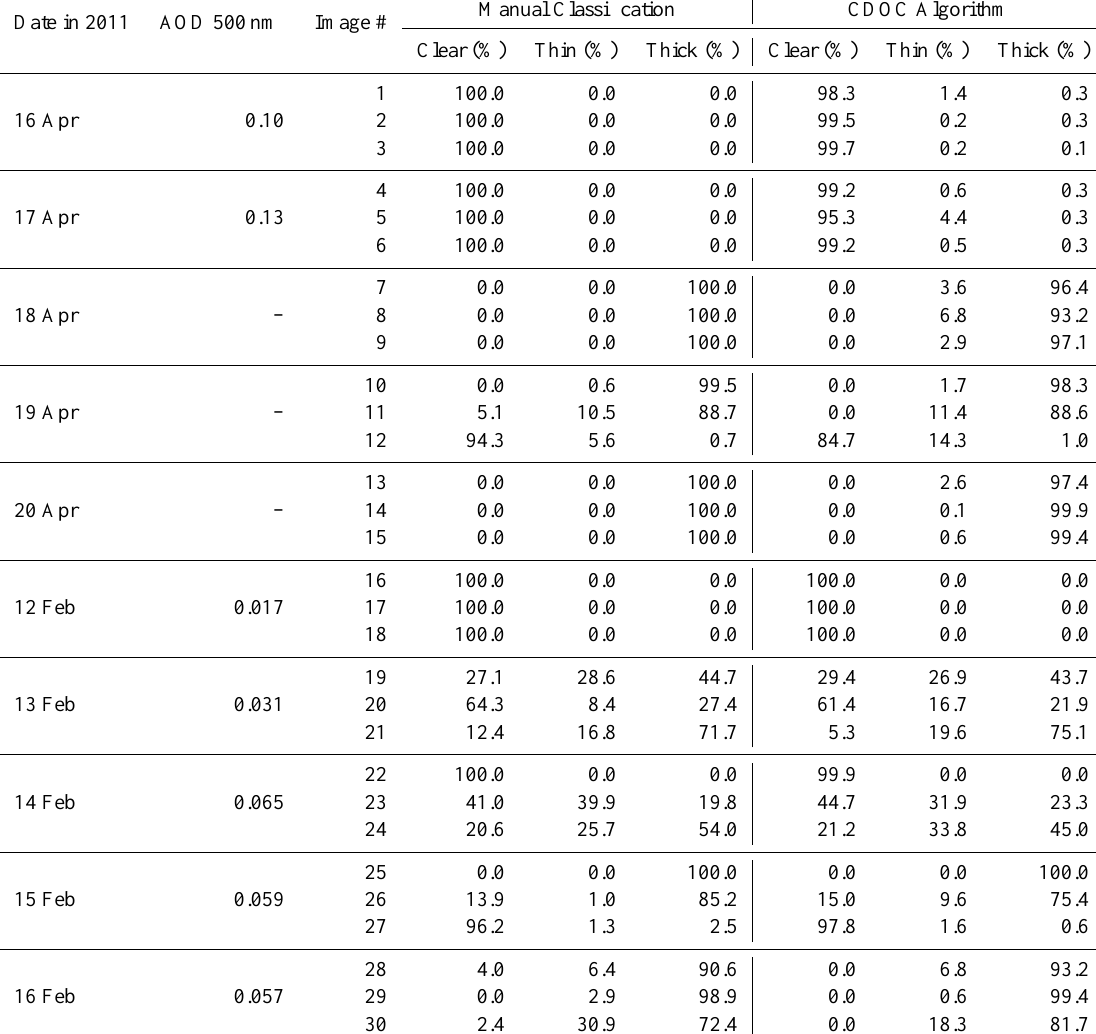
Table 4. Results of manual classification and CDOC algorithm for the validation images as well as AOD measurements at 500nm averaged during the time period of the sky images. Note that for overcast skies (18–20 April) there are no AOD measurements.